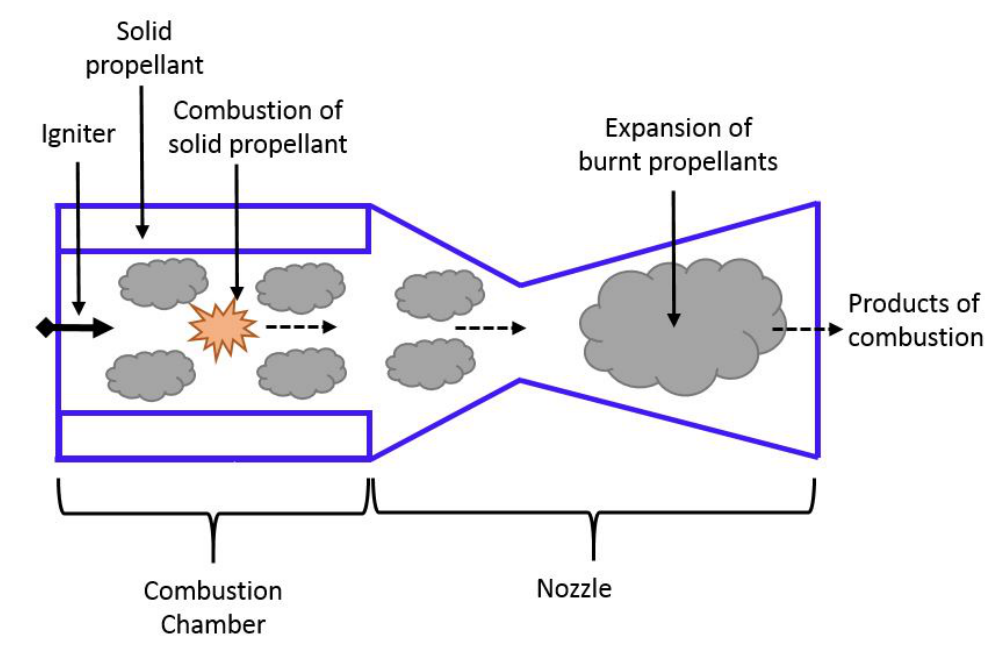
Figure 3. Schematic of a Solid Propulsion